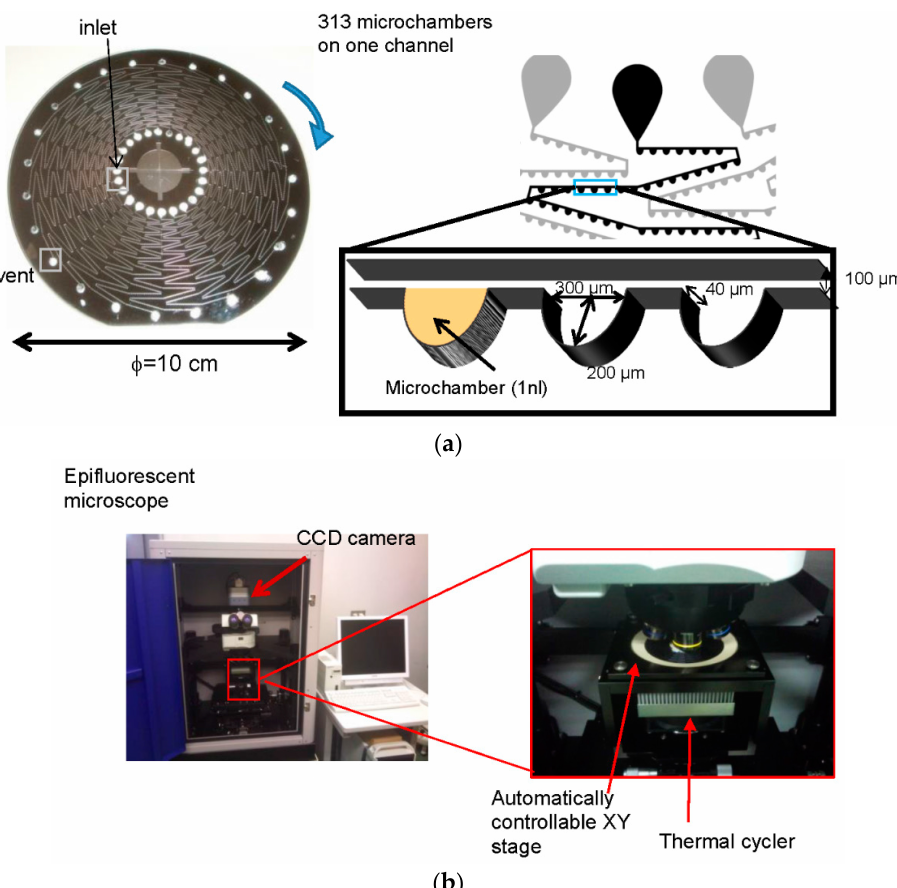
Figure 1. ( a ) design of the CD-shaped device; ( b ) the detection system was fabricated to acquire images of all microchambers automatically.